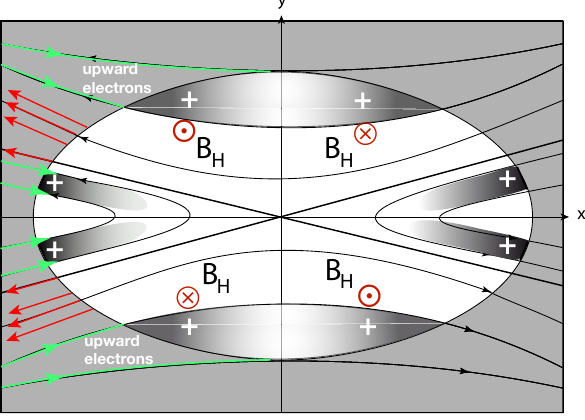
Fig. 4. Schematic of the region of electromotive potentials in the Hall domain of a stationary reconnection region approximately transforming the inference of the simple (rectangular) analytical model to the probable elliptic shape of the reconnection site around the X-point. The figure shows the approximate regions of positive electromotive potentials in shading (upward electrons indicated by green arrows). Darker shading means larger potentials. The main domain of positive electromotive potentials is found in the outer part of the inflow region of the Hall domain. Two narrow regions of positive electromotive potential should, however, also exist in the outflow region. The large area left white contains negative electro- motive potentials with the exception of a horizontal stripe including the central current sheet where no Hall fields exist. This stripe is principally empty of any electromotive potentials. Also the very narrow region of maximum Hall fields (not shown) is exempt from any electromotive forces because of the vanishing field gradient. The red arrows indicate down-flowing electrons which have been accelerated during reconnection. The fastes electrons are expected to leave along the separatrices, i.e. from the X-line where they have been accelerated out of the current sheet electron reservoir.